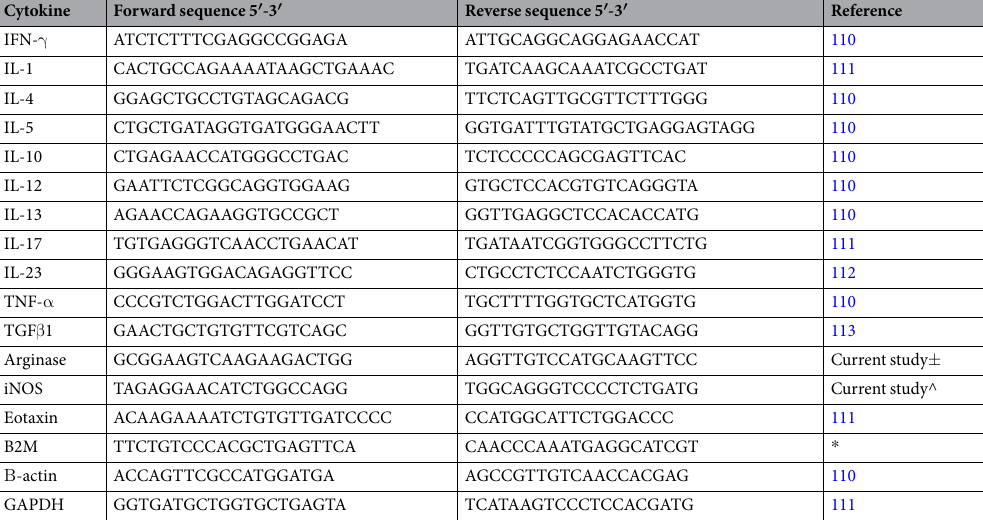
Table 1. Primers for quantitative PCR (qPCR) cytokine analysis. * Pacheco, I.L., personal communication. ± Based on Ovis aries arginase 1 (XM_004011324). ^Based on the bovine sequences from Adler et al . 114 using the Ovis aries nitric oxide synthase 2 gene (XM_004012488).